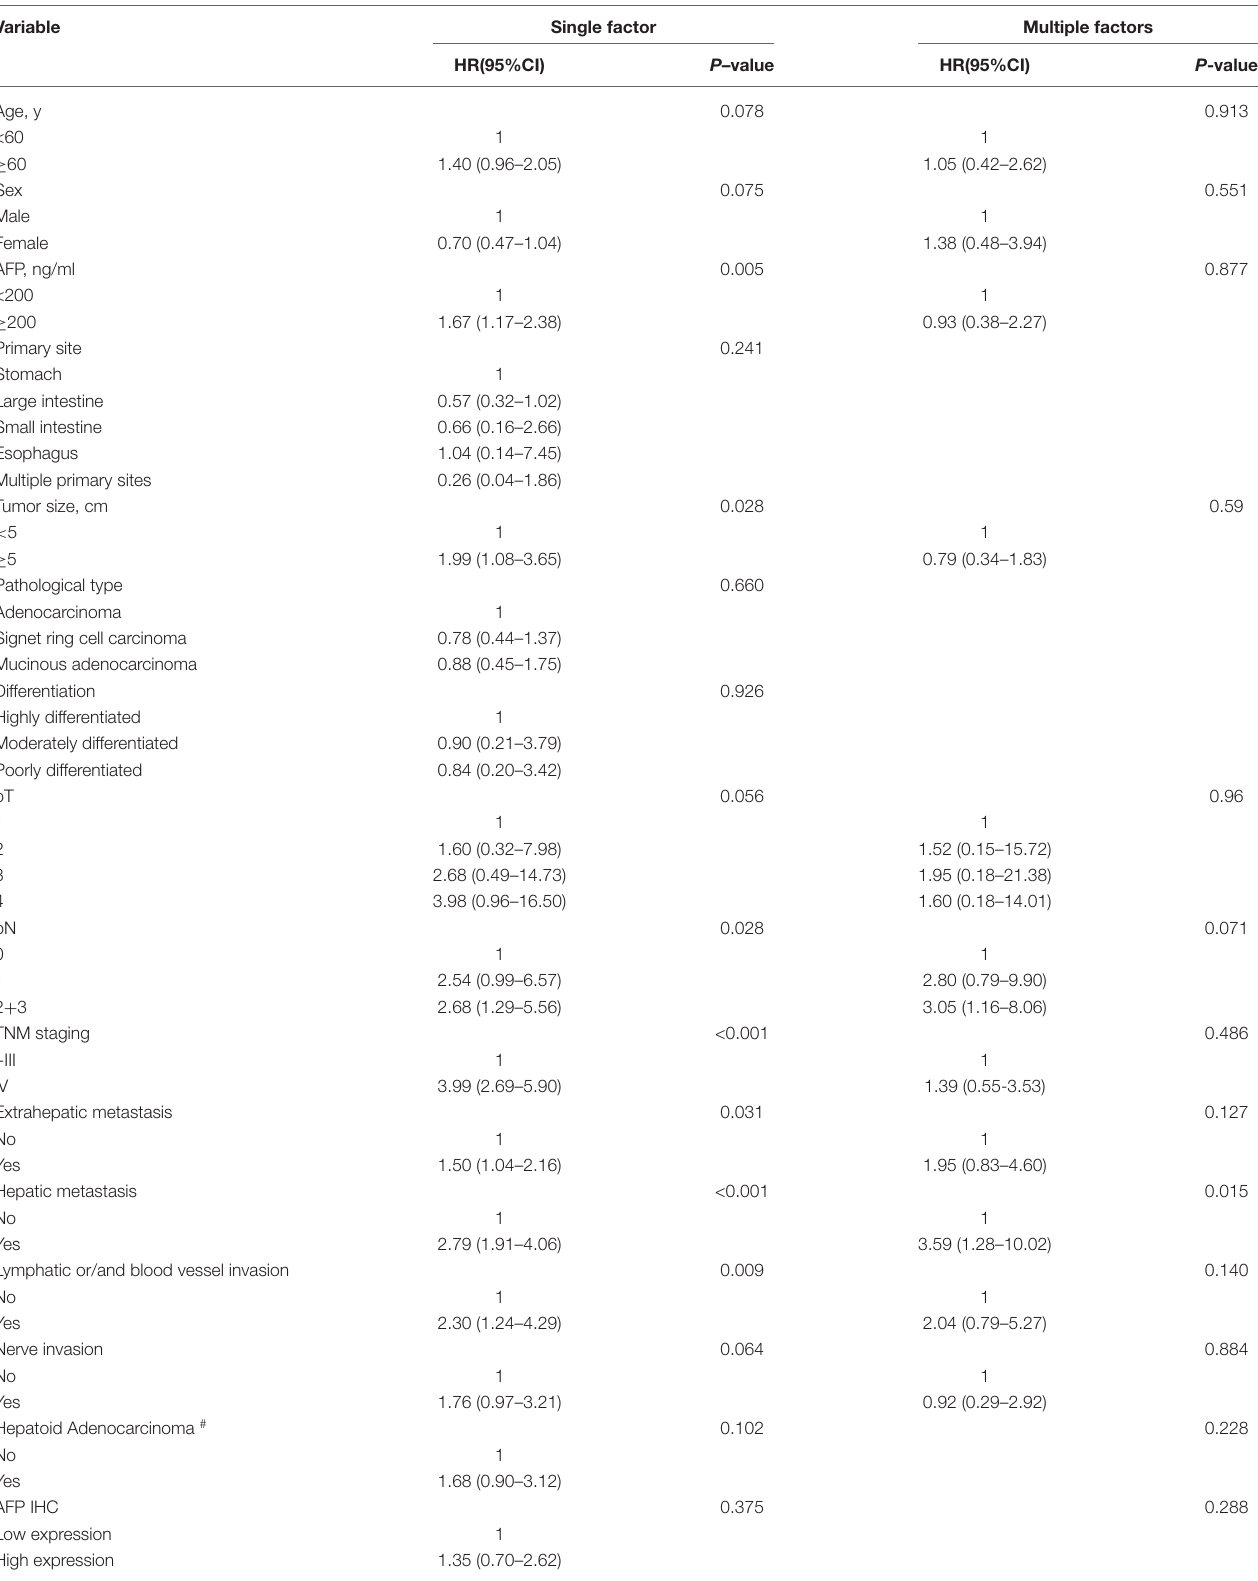
TABLE 4 | Regression analysis for prognostic risk factors of